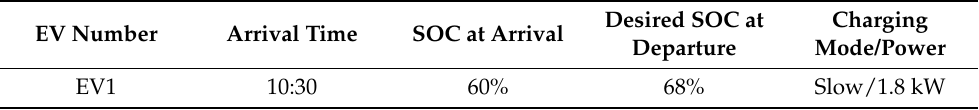
Figure 7. Solar irradiation and PV maximum power point tracking (MPPT) power—Case 1. Table 1. Hypotheses for Scenario